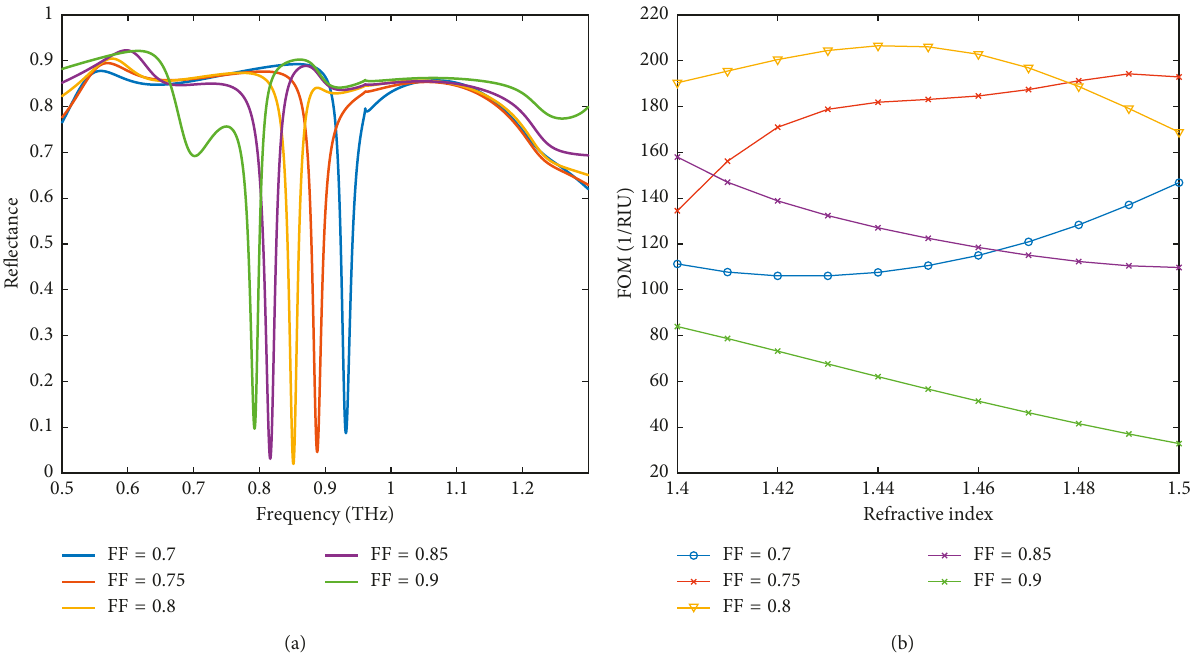
Figure 4: A variation of FF in Au-coated PDMS grating with Λ � 190 μ m, H � 95 μ m, and t Reflectance as a function of frequency. (b) FOM as a function of refractive